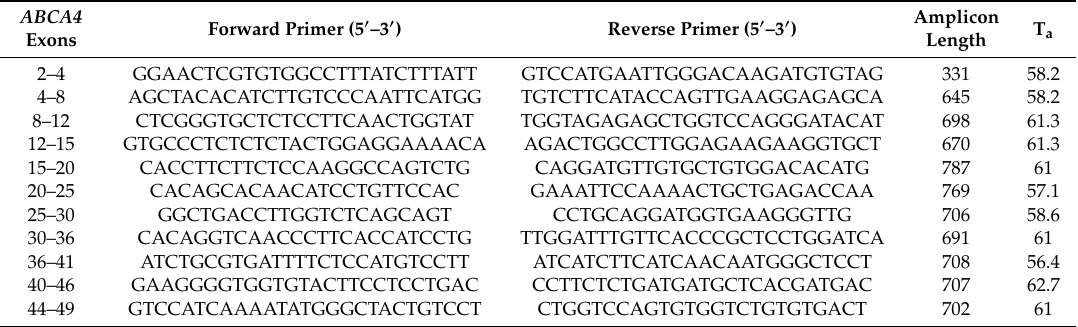
Table 3. List of set of primers and annealing temperatures (T a ) used during ABCA4 transcript